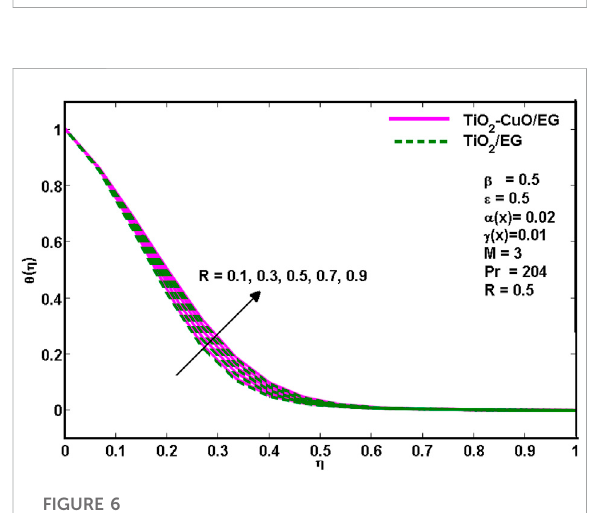
FIGURE 6 Effects of temperature pro fi les for various R .